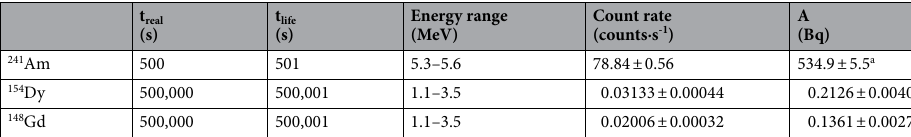
Table 3. Activity (A, in Bq) of the 154 Dy electrodeposited on the graphite foil, together with the activity of the 148 Gd impurity. a Activity of the source at the date of the efficiency calibration (20.07.2021), calculated using (432.6 ± 0.6) y as the half-life of 241 Am, as reported in 45 . The activity of the 241 Am standard source